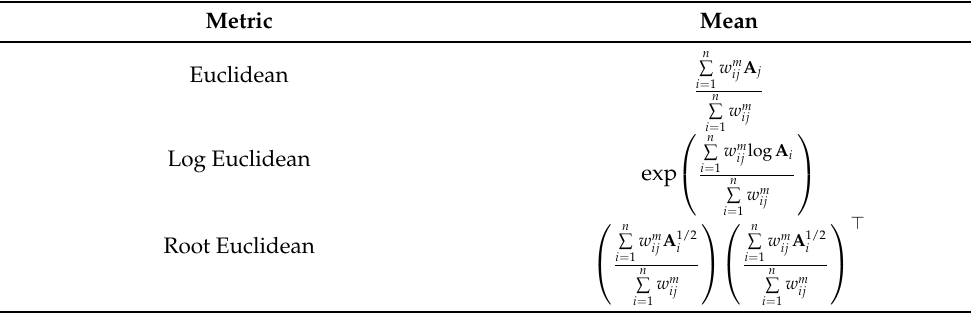
Table 2. Weighted mean ¯ A using the Euclidean, log, and root